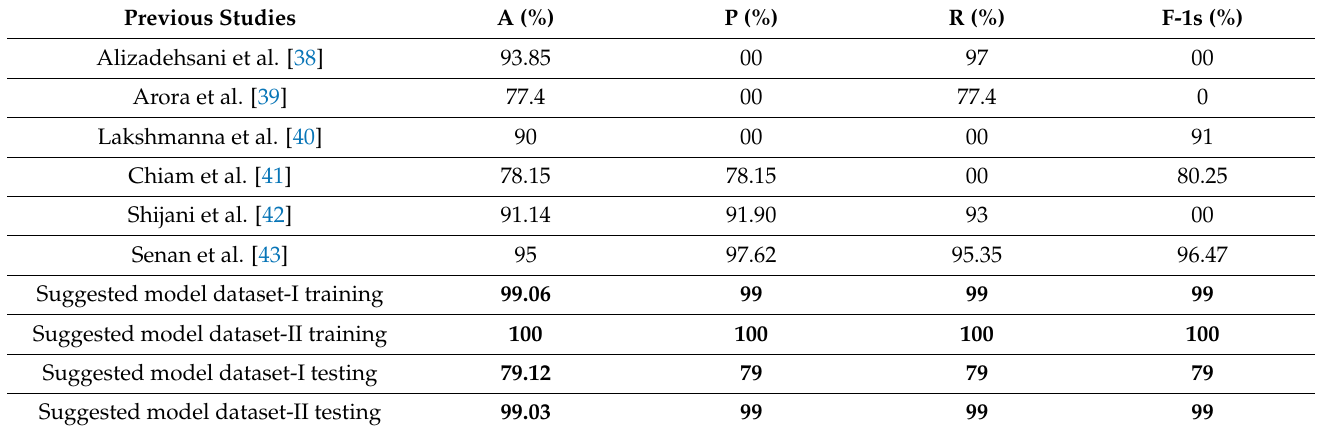
Table A7. Comparison of the performances between the suggested system and previous